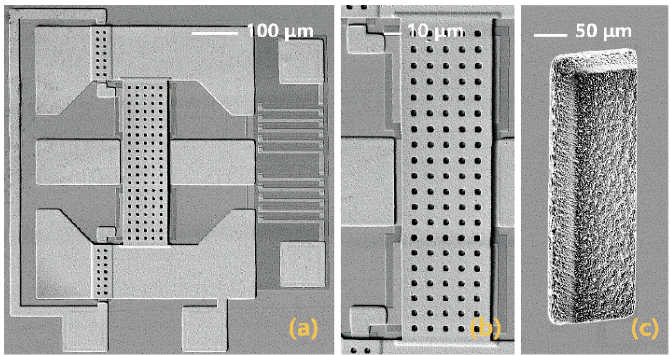
Figure 6. SEM image: ( a ) cascaded MEMS demodulator; ( b ) MEMS clamped ‐ clamped beam and ( c ) backside ‐ etch structure and blind hole. Table 1. Structural parameters for cascaded MEMS amplitude demodulator.